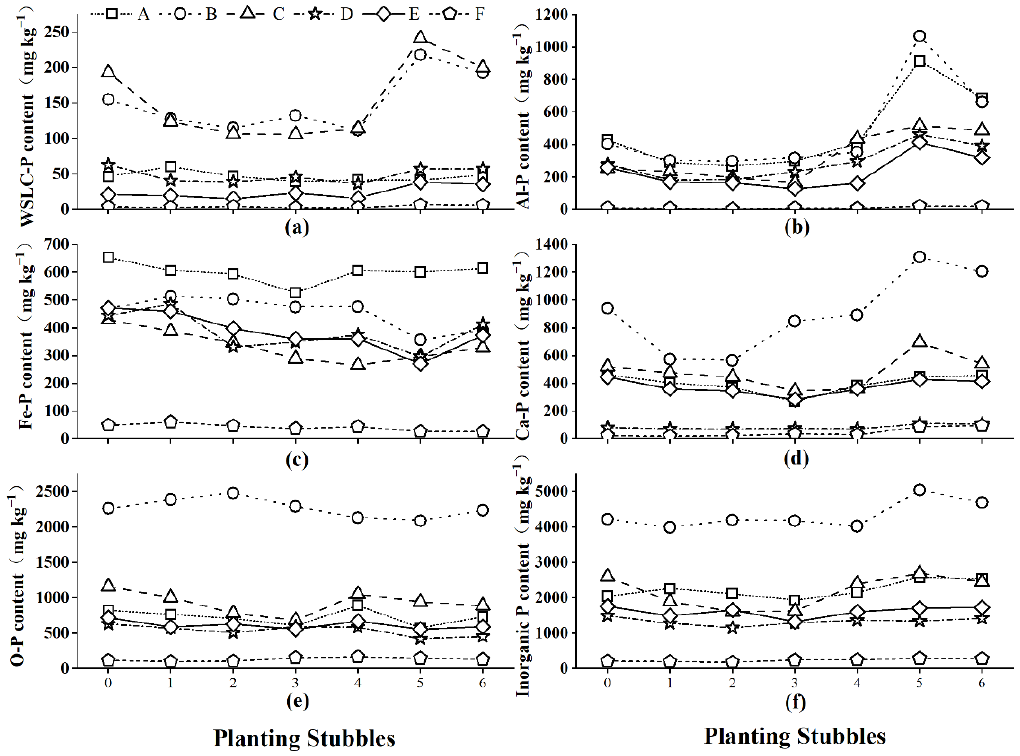
Figure 1. The changes of inorganic phosphorus sources in the studied soils over successive planting stubbles: ( a ) WSLC--P; ( b ) Al-P; ( c ) Fe-P; ( d ) Ca-P; ( e ) O-P; ( f ) total inorganic phosphorus.